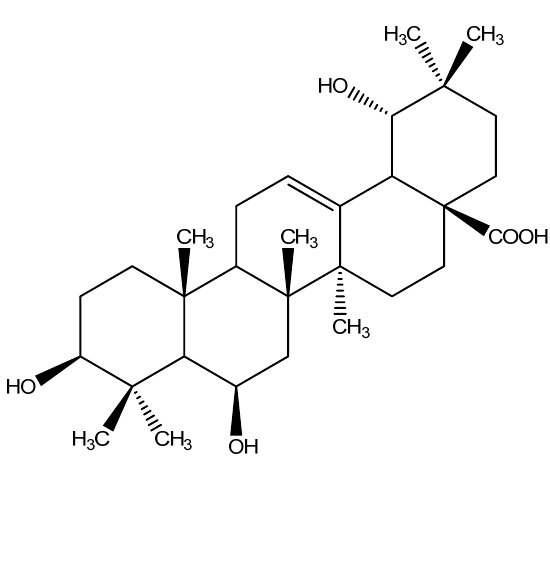
Figure 1. Structure of compound 1